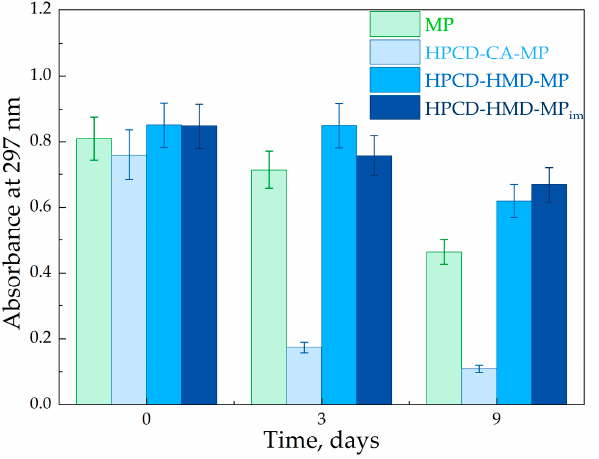
Figure 7. The diagram of MP’s spectrum intensity at 297 nm for MP, HPCD-CA-MP, HPCD-HMD-MP, and HPCD-HMD-MP im , T = 22 °C.